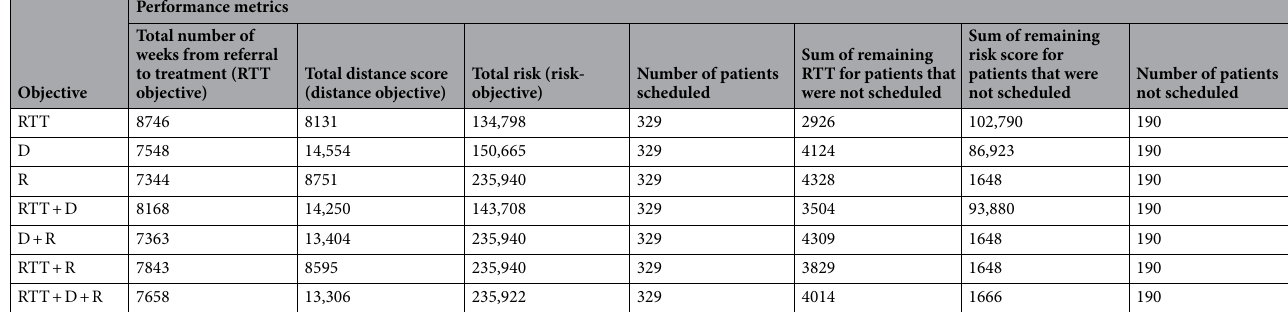
Table 2. Model outcome showing the results by maximizing the individual and combined objectives (column objective). The first line reveals a solution in which the model is optimized using RTT with the maximum